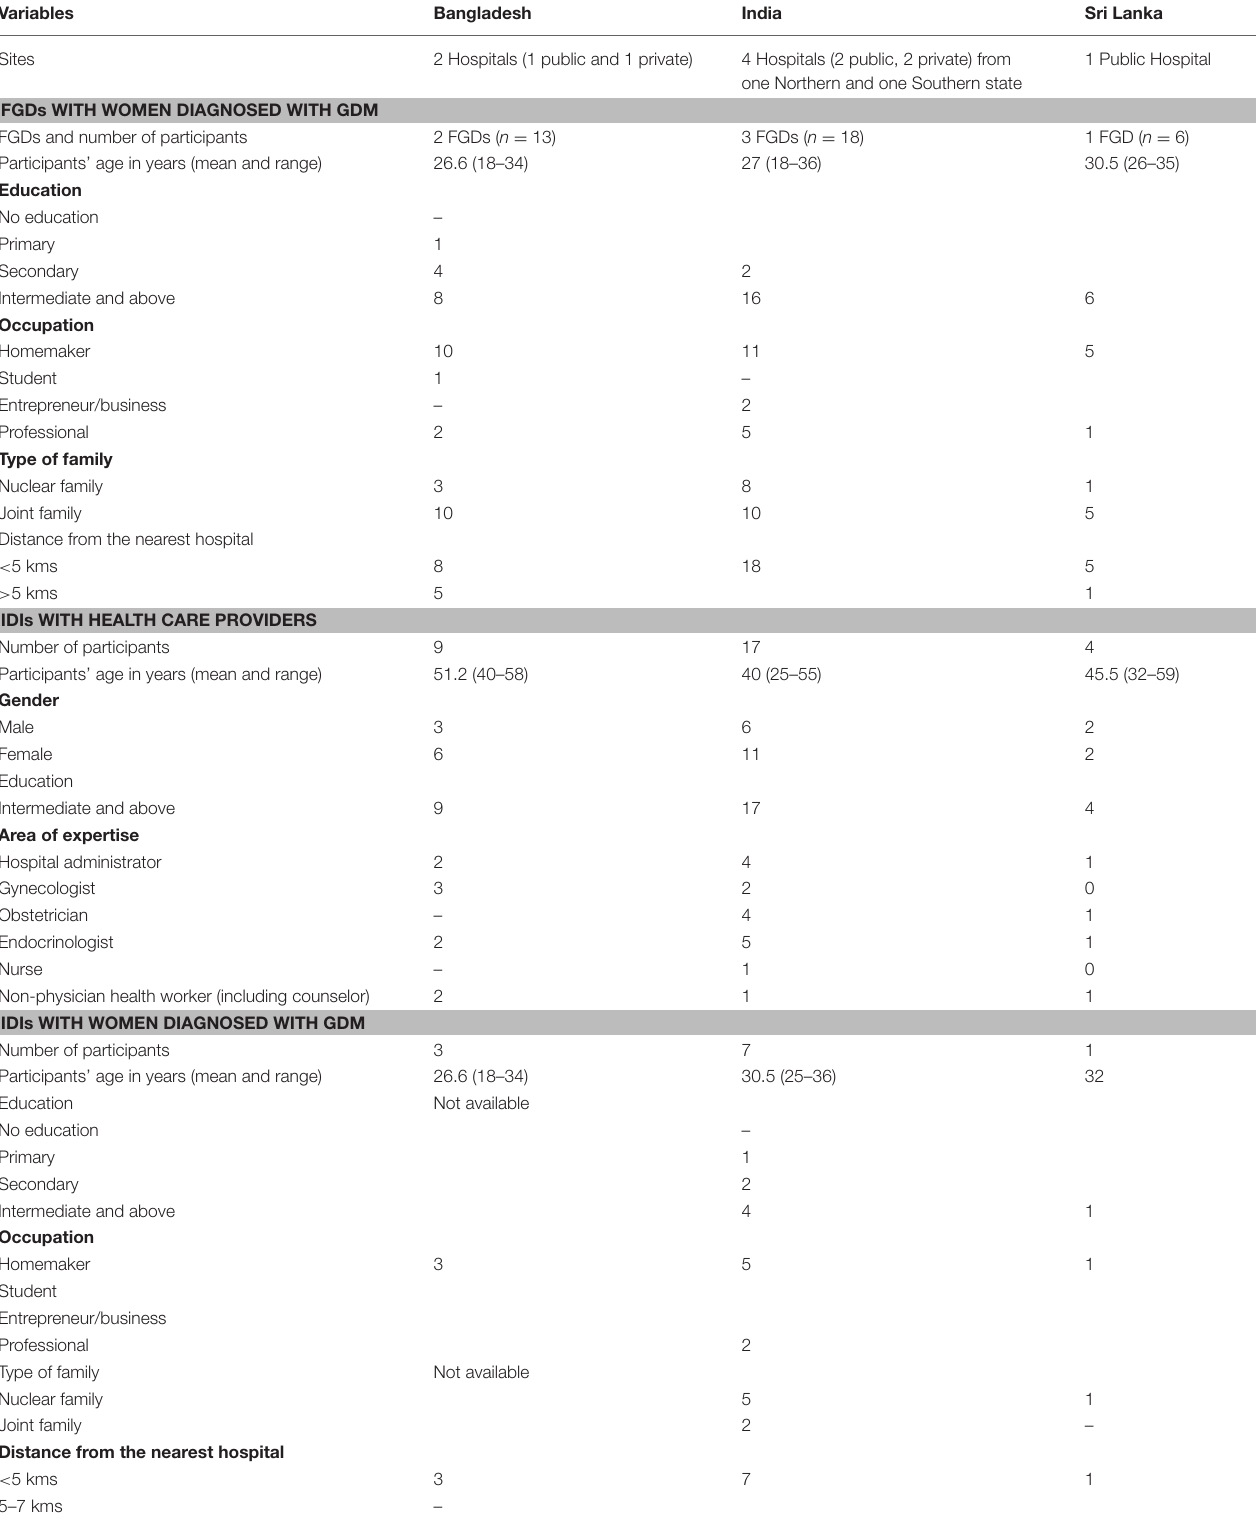
TABLE 2 | Characteristics of participants in FGDs and IDIs in three countries.